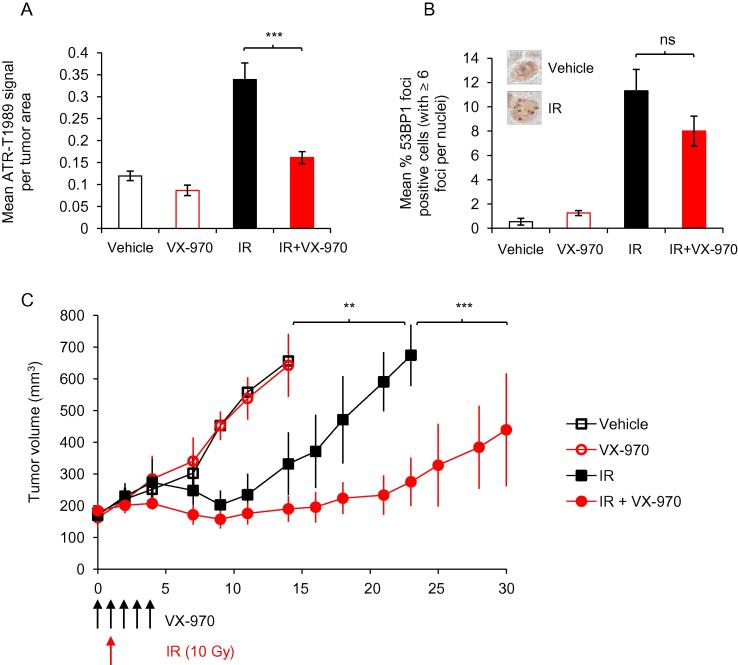
VX-970 treatment improves radiation response in vivo. (A-B) OE21 xenografts were collected on day 3 of the VX-970 treatment/one day after radiation (10 Gy), formalin fixed and paraffin-embedded. Immunohistochemical images of phosphorylated ATR-S1989 and 53BP1 foci (examples shown in Fig. S5C and D) were quantified. Bar graph showing the mean ± SEM signal from phospho-ATR-T1989 staining from at least 20 section areas analyzed for each condition (at least 2 tumors per condition) (A). Bar graph showing the mean ± SEM percent of cells per section area positive for 53BP1 foci (>6 foci per nuclei, examples shown in the insert boxes) from at least 20 section areas analyzed for each condition (at least 2 tumors per condition) (B). One-way ANOVA test, followed by student t test for each comparison shows statistical significance; ***P < 0.001, ns non-significant. (C) Tumor growth rates were determined for the 4 tumor groups indicated. Graph shows mean ± SEM (n = 4 in each group) analyzed with a two-way ANOVA test between individual groups; **P < 0.01, ***P < 0.001.